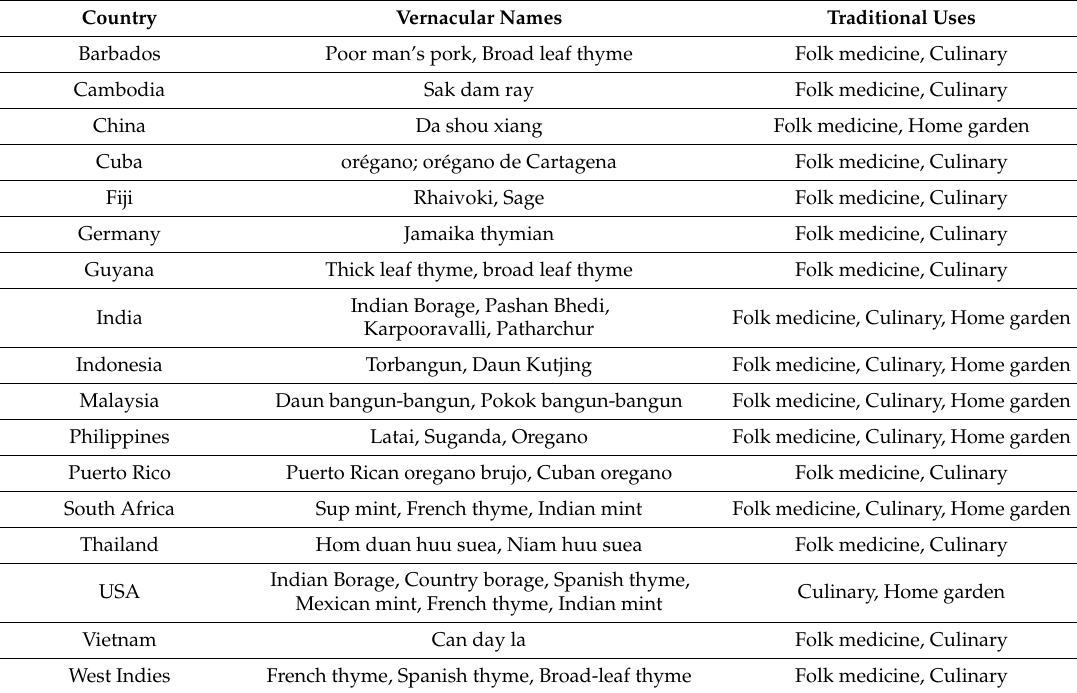
Table 1. Vernacular names and traditional uses of Plectranthus amboinicus commonly used by locals in their respective